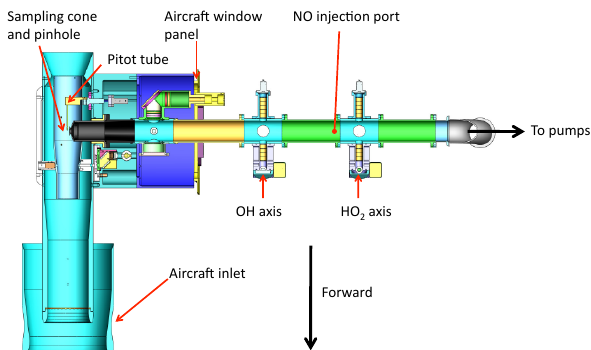
Fig. 2. Fluorescence cell for the sequential detection of OH and HO 2 . OH is detected in the first axis, with fluorescence collected perpendicular to the laser beam and sample flow. NO is then in- jected to titrate HO 2 to OH and the signal due to HO 2 is detected in the HO 2 axis with fluorescence collection also perpendicular to the laser axis and sample